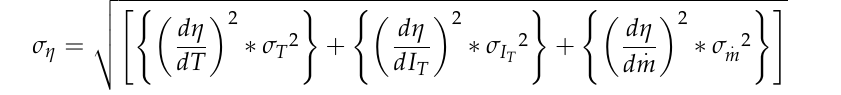
Table 7. Instrumentation used during experimentation and their uncertainty. Parameter Measuring Instrument Uncertainty Solar radiations Pyranometer ± 2% Inlet, outlet, and ambient temperatures K-Type thermocouple ± 0.1 ◦ C Flow rate Water flow meter ±